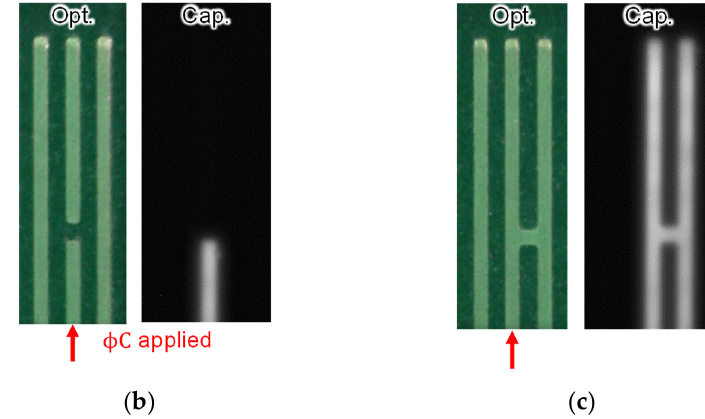
Figure 18. Captured images of printed circuit board wiring by optical image sensor and Chip A: ( a ) no defects; ( b ) open defect; ( c ) short defect. φC was applied only to the center wire indicated by the ( a ) no defects; ( b ) open defect; ( c ) short defect. ϕ C was applied only to the center wire indicated by red arrows. the red